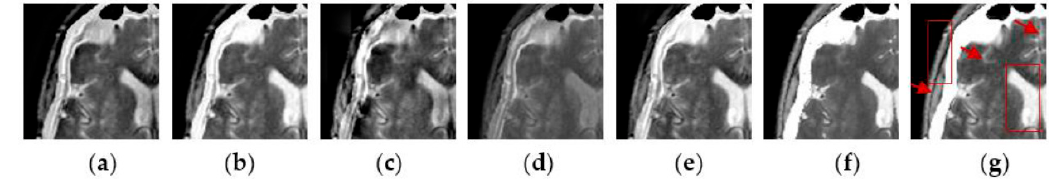
Figure 11. Enlarged views of fused results of ROIs denoted by the red boxes in Group 1 in Figure 6 for the seven methods: ( a ) the DWT method; ( b ) the NSCT method; ( c ) the NSCT-SR method; ( d ) the m-PCNN method; ( e ) the PCNN-NSCT method; ( f ) the SCM-F method; and ( g ) the SCM-M method.